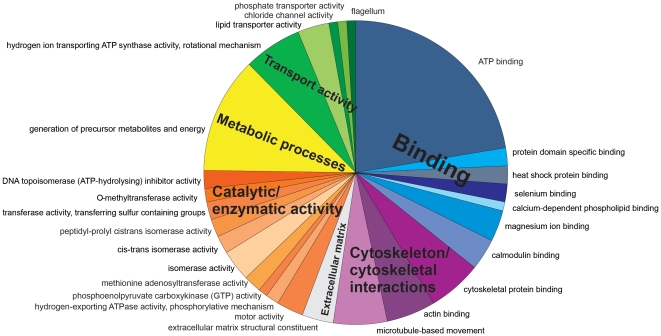
Classification analysis for Acropora millepora transcripts that were differentially expressed across pCO2 treatments (control, medium and high) at day 1 and 28.Gene enrichments (P<0.05) across GO categories are shown. The program GOEAST was used to test for enriched GO categories among differentially expressed genes. Color scheme indicates parent categories (binding, actin cytoskeleton, catalytic activity, metabolic processes and transporter activity) and individual pie segments are annotated for more specific GO categories. The sizes of the pie segments are proportional to the total number of genes enriched. The proportion of differentially expressed genes which were assigned to gene ontology categories was 55%.